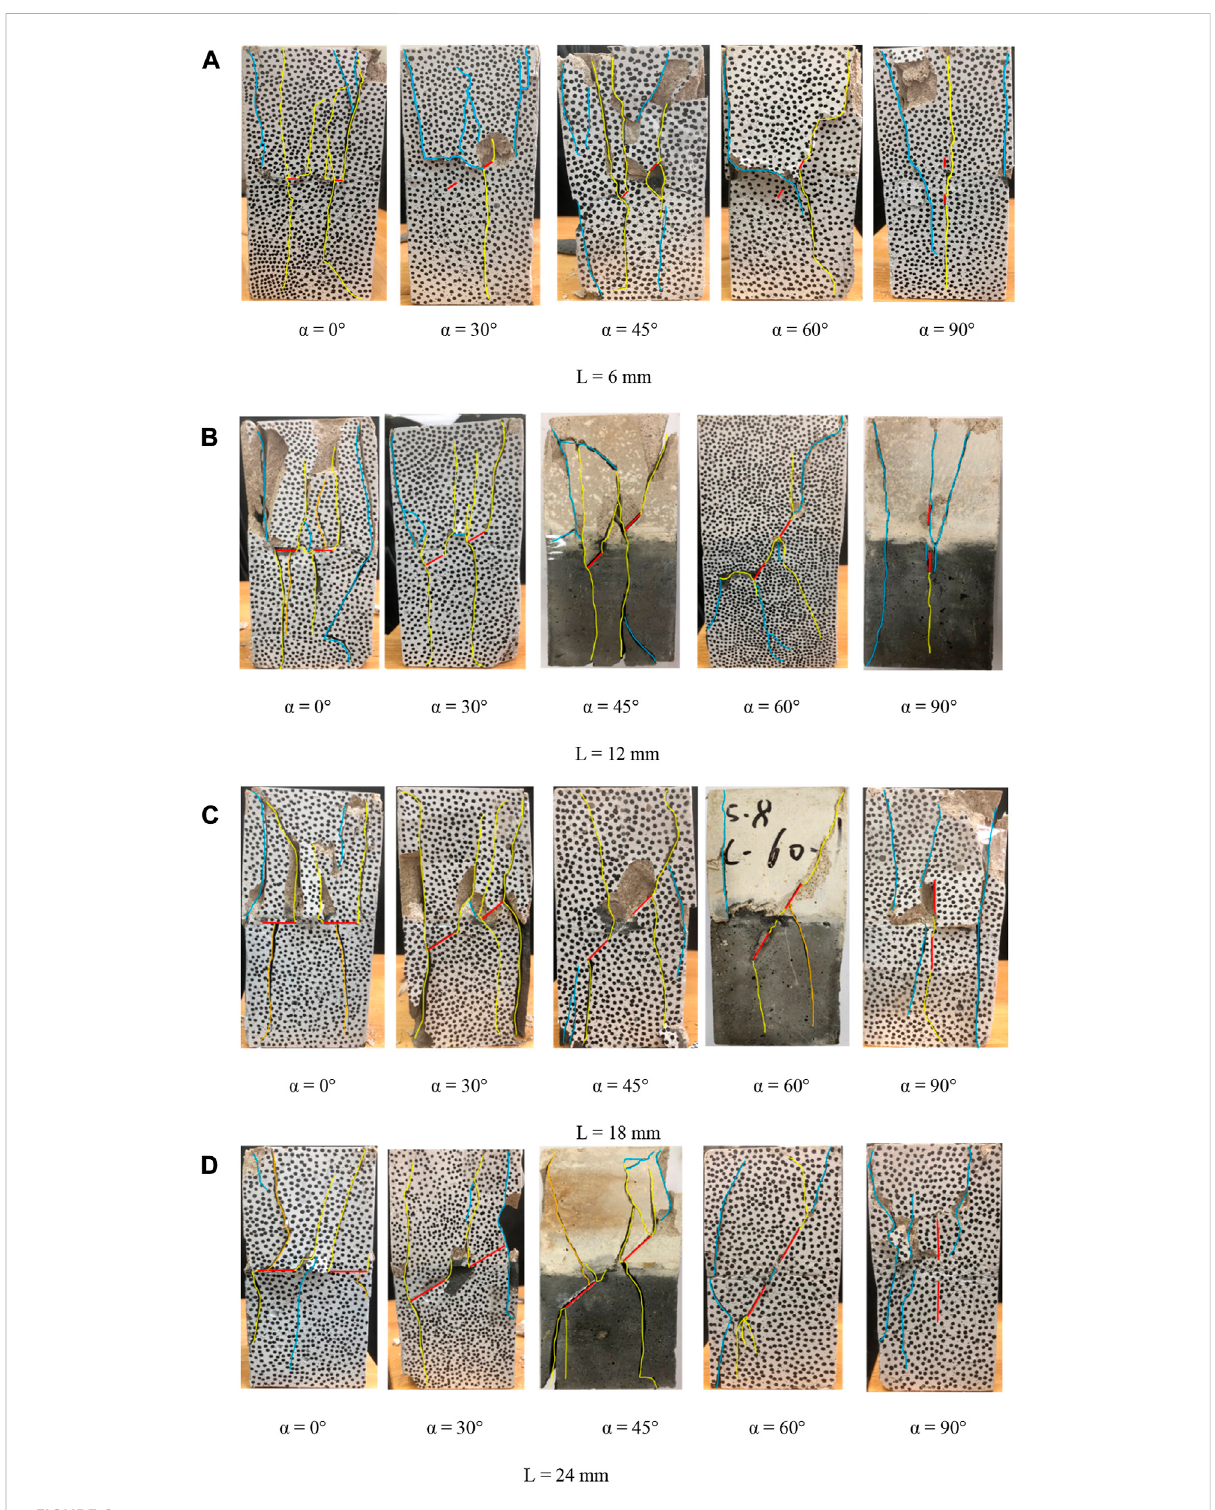
FIGURE 8 Final failure modes of composite rock samples with different fracture angles and lengths (A) L = 6 mm (B) L = 12 mm (C) L = 18 mm (D) L = 24